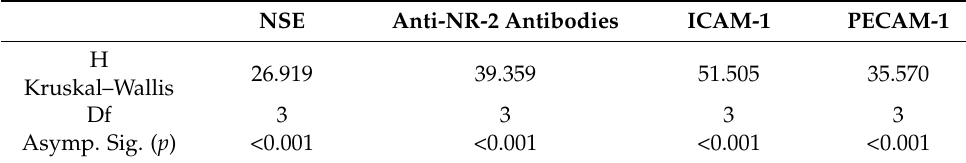
Table 5. Kruskal–Wallis test for all studied